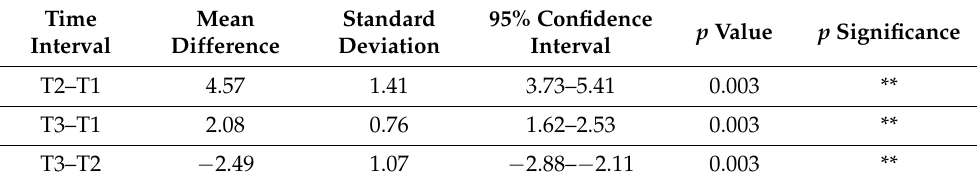
Table 12. Results of the mean differences (mm) of Aperture of Midpalatal Suture 11.